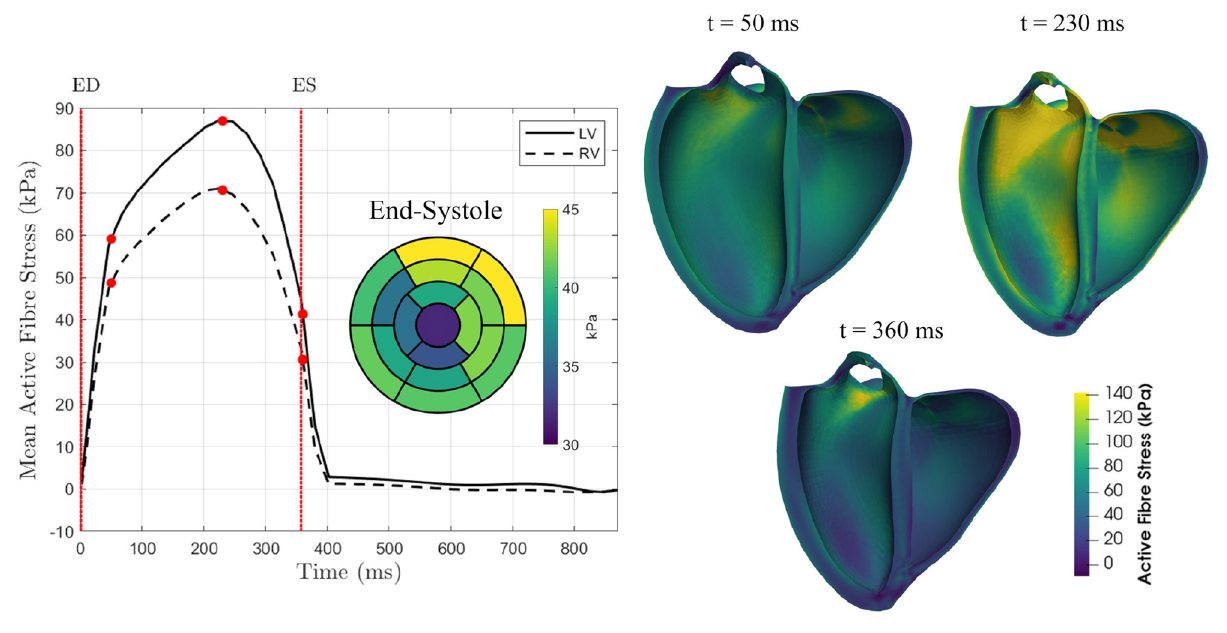
Frontiers in Physiology |